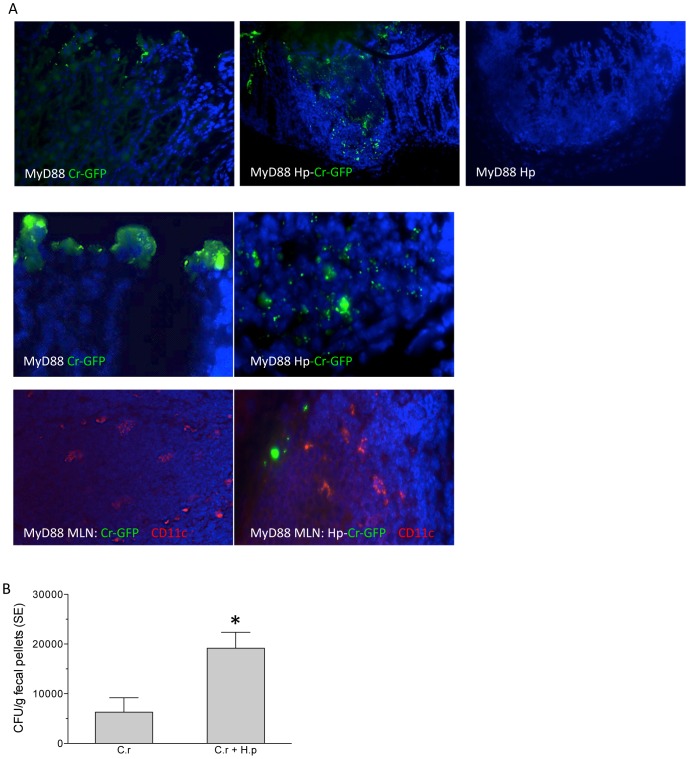
Helminth infection results in enhanced C. rodentium translocation in colonic tissue of MyD88 KO mice.
A. Immunofluorescence microscopic analysis of bacterial distribution and localization in the colonic tissues at day 5 post C. rodentium infection. Most of the bacteria were detected in the intestinal epithelial surface in MyD88 knockout mice with bacterial infection alone. An increased bacterial translocation was detected in MyD88 knockout mice with helminth-coinfection. Green: GFP-C. rodentium, Blue: DAPI. Red: CD11c in MLN. B. Numbers of bacteria recovered from fecal samples of C. rodentium-infected and co-infected MyD88 knockout mice at 7 days post-infection. The data shown are represented as the mean ± the SEM (n = 6 to 7 mice). *p<0.05.